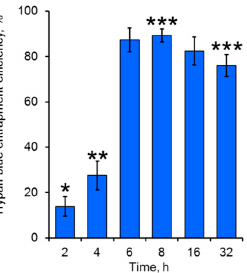
Figure 1. Polyelectrolyte shell formation and optical encoding with quantum dots (QDs) using a layer-by-layer deposition: ( a ) the scheme of the polyelectrolyte and QD deposition onto the calcium carbonate microparticle surface; ( b ) microphotographs of the synthesized calcium carbonate template microparticles (1) and resultant QD-encoded microcapsules (2). The fluorescent image was obtained using an XF115-2 FITC long pass filter set consisting of a 505DRLP dichroic filter, a 475AF40 excitation filter, and a 510ALP emission filter.